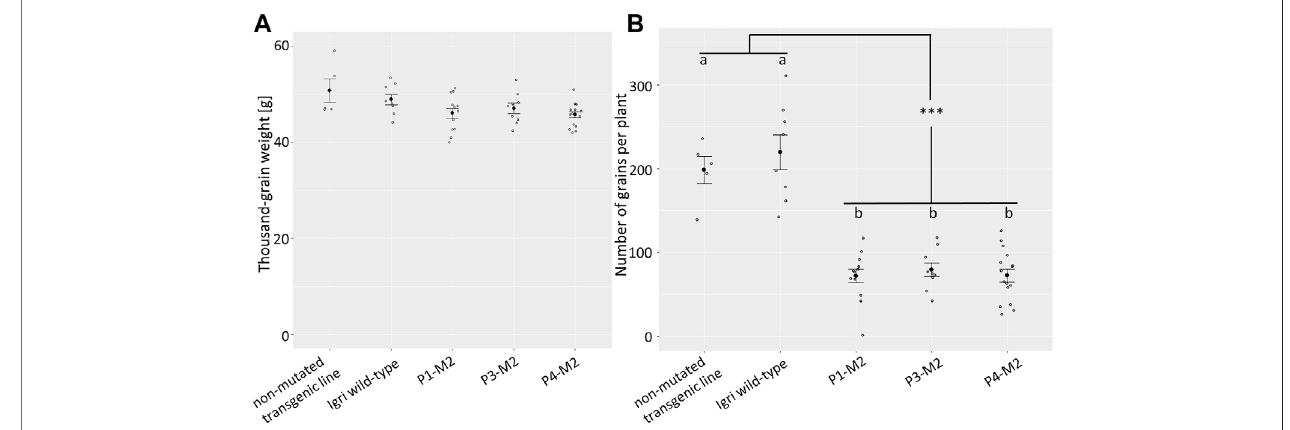
FIGURE 4 | (A) Thousand-grain weight of three M2 populations (9 – 16 siblings each), compared to non-mutated segregants from a comparable transformation experiment ( n (cid:1) 5) and “ Igri ” wild-type ( n (cid:1) 8), grown under the same conditions. Black dots show the average weights of 1,000 grains in g, error bars indicate standard errors. Statistically signi fi cant differences were not detectable (Tukey ’ s test, p ≥ 0.05). (B) Total number of grains per plant of three M2 populations (9 – 16 siblings each), compared to non-mutated segregants from a comparable transformation experiment ( n (cid:1) 5) and “ Igri ” wild-type ( n (cid:1) 8), grown under the same conditions. Black dots show the average numbers of grains per plant, error bars indicate standard errors. Samples without statistically signi fi cant differences (Tukey ’ s test, p > 0.8) are indicated by same letters, statistically signi fi cant differences between the two groups indicated by ‘ *** ’ (Tukey ’ s test, p <